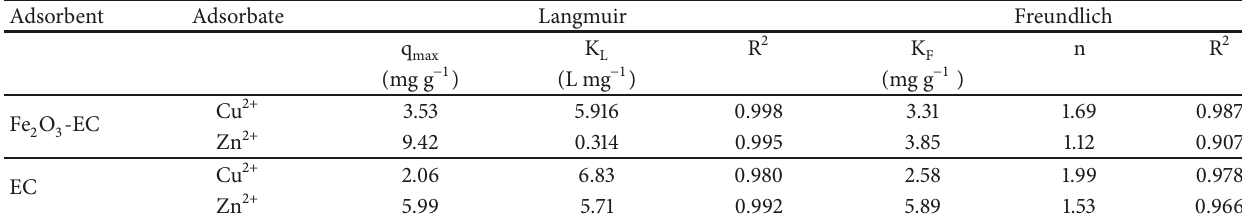
Table 2: Langmuir and Freundlich constants for the metal ions adsorption on Fe 2 O 3 -EC. Adsorbent